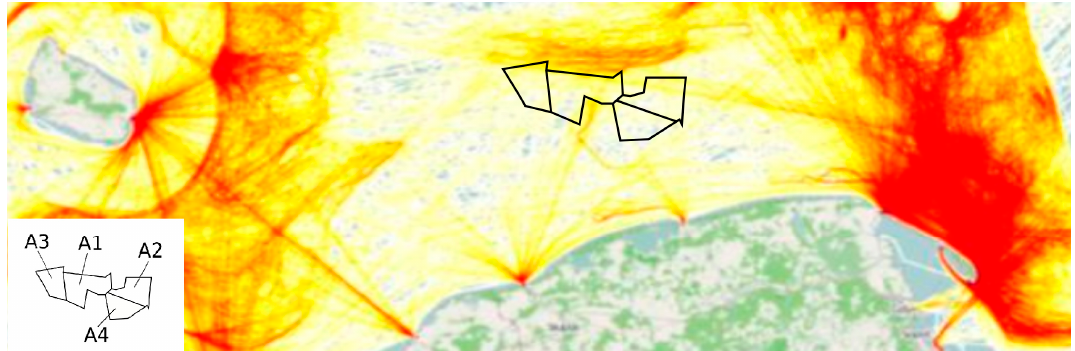
Figure 6. The decision variants on the background of fishing routes.